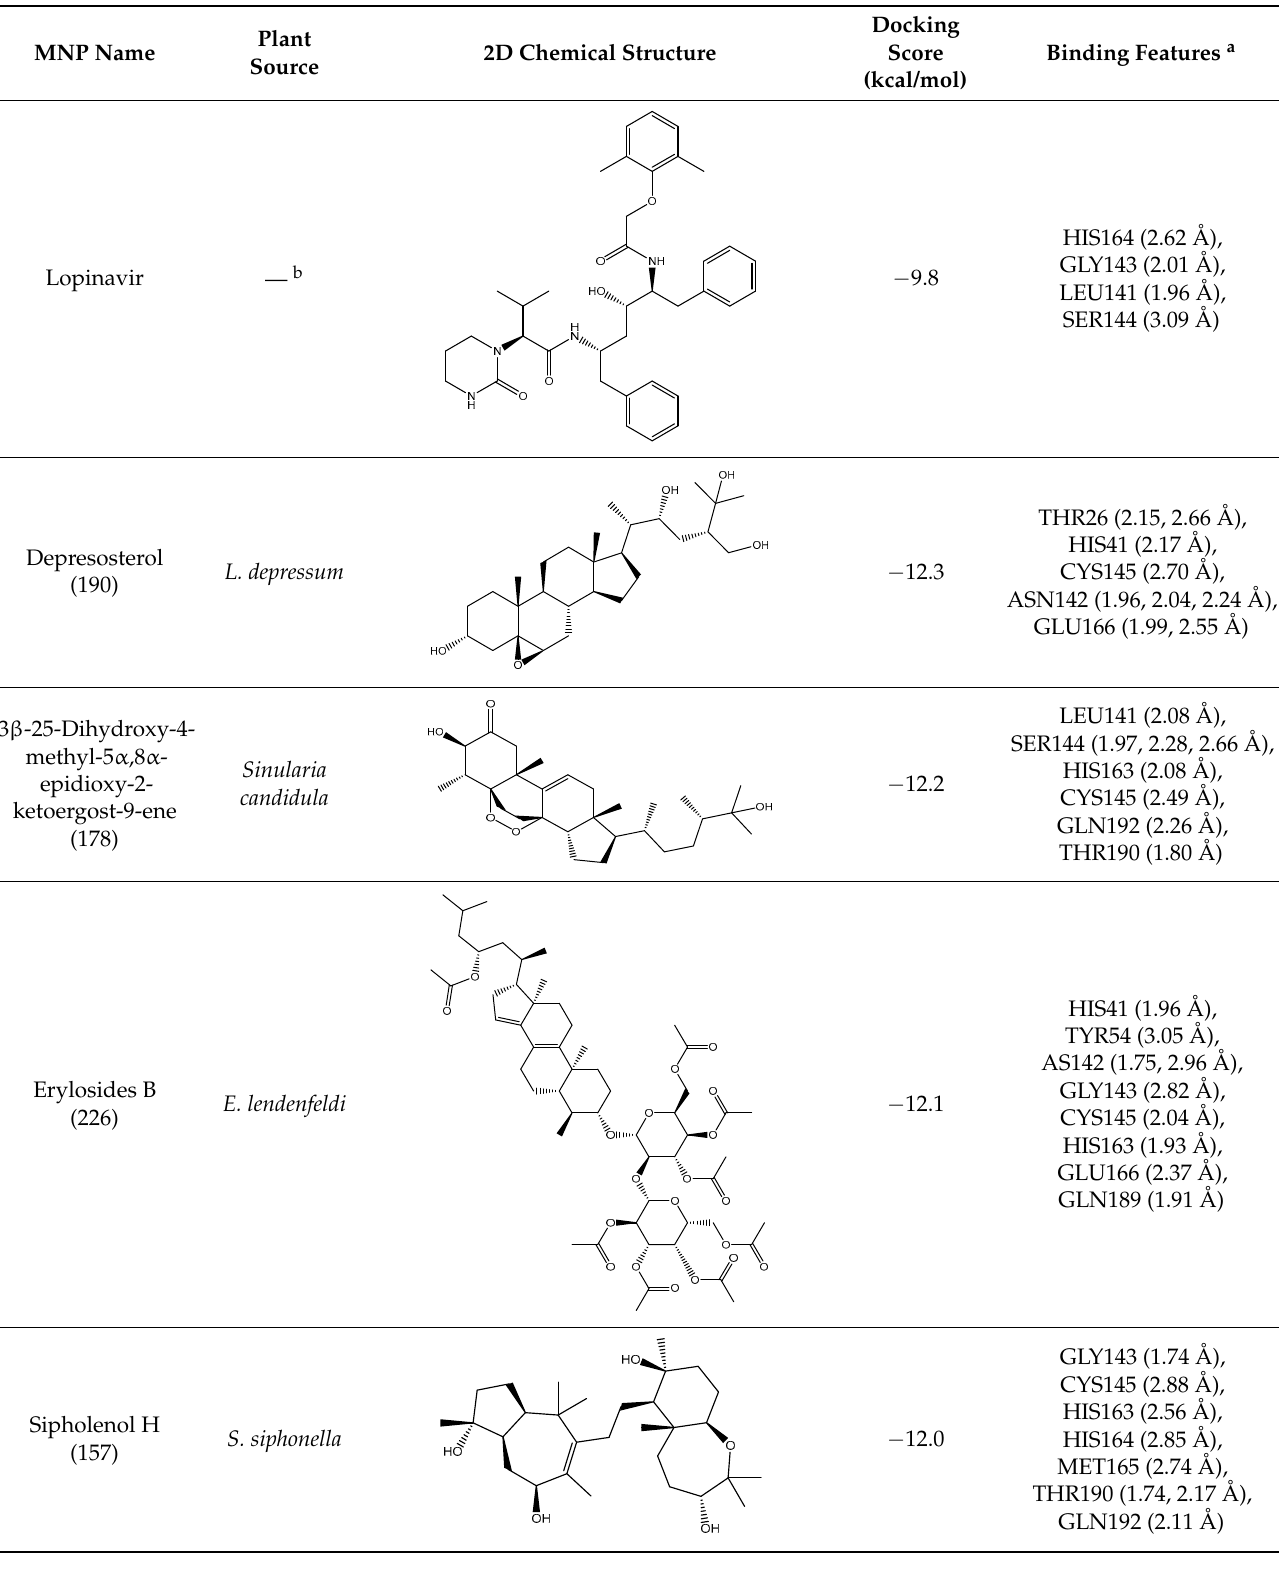
Table 1. Estimated docking scores, 2D chemical structures, and binding features for lopinavir and the top 27 potent marine